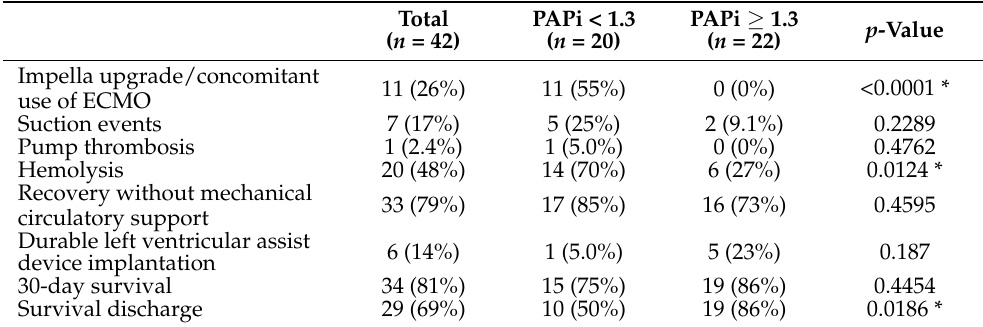
Table 6. Clinical outcomes.